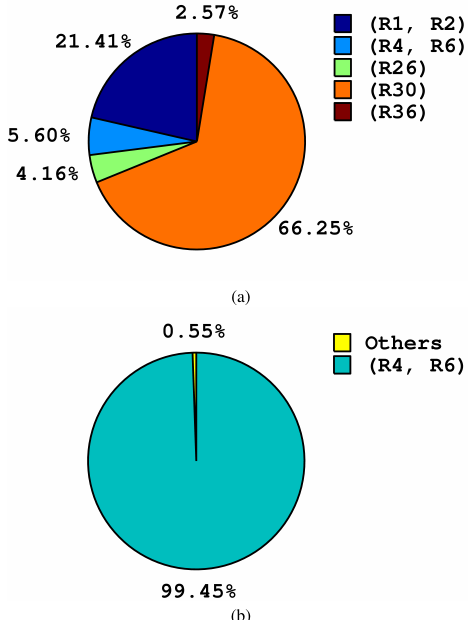
Fig. 5. Instantaneous contribution of various reactions and combi- nations of reactions to ozone depletion at (a) day 2 (induction stage) and (b) day 6 (depletion